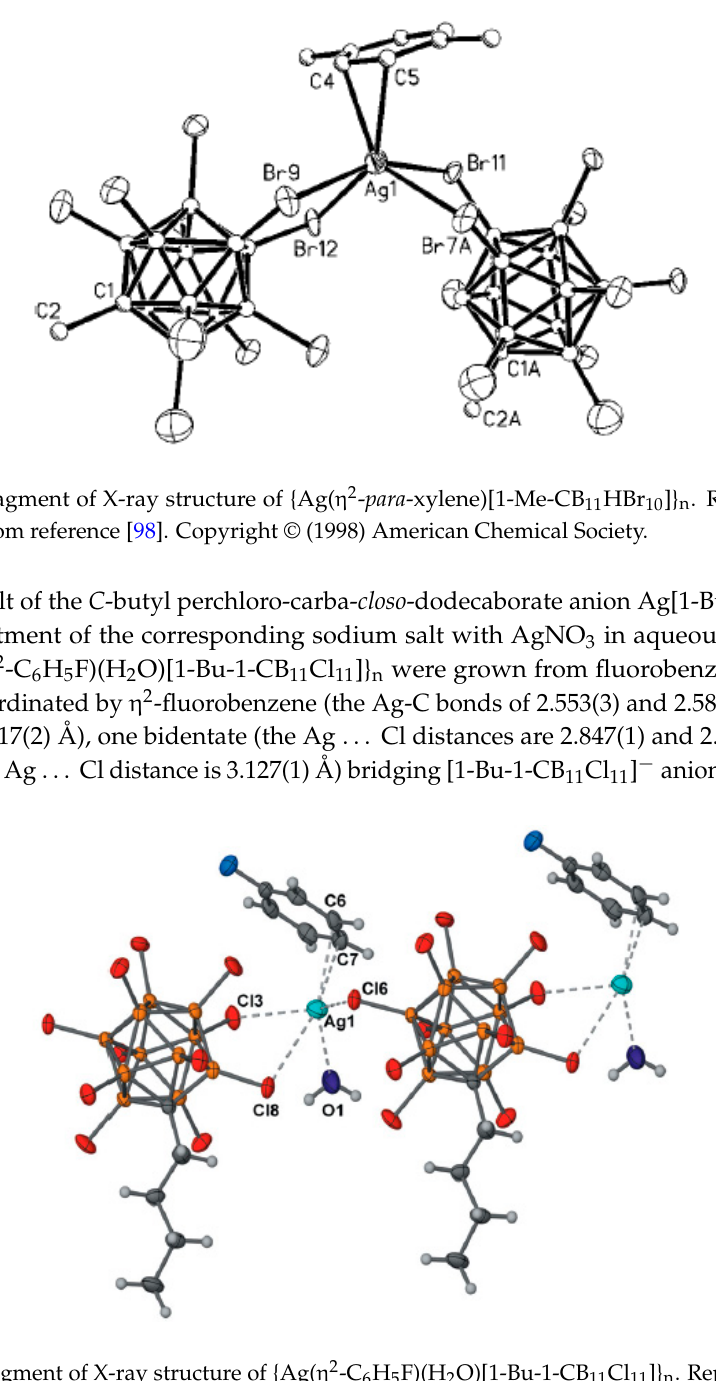
Figure 78. Fragment of X-ray structure of {Ag( η 2 -C 6 H 5 F)(H 2 O)[1-Bu-1-CB 11 Cl 11 ]} n . Reproduced from reference [100] with permission from The Royal Society of Chemistry.